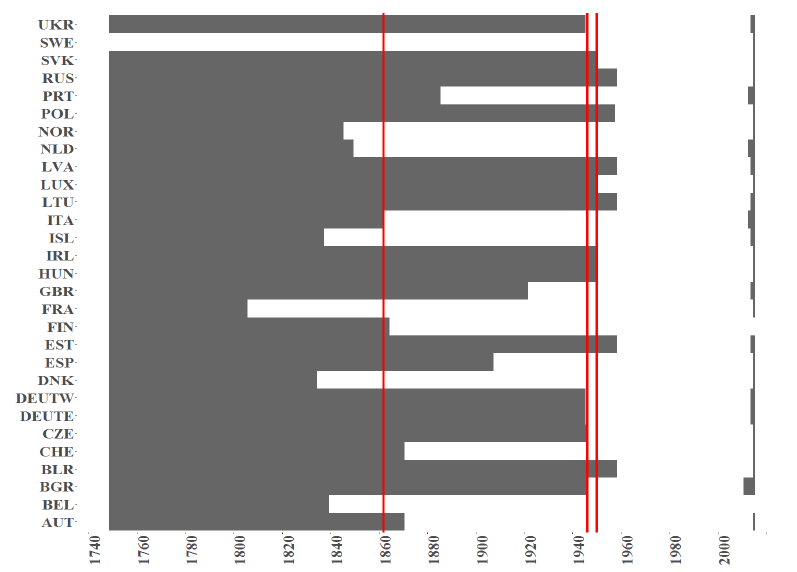
Figure 2. The indicator of a missing value (black colour) per country (y axis) over time (x axis) for the Births counts for female population. Red vertical lines correspond to the starting points in time when samples with maximum of missing entries is equal to (from the left side on corresponding plots) 75%, 50% and